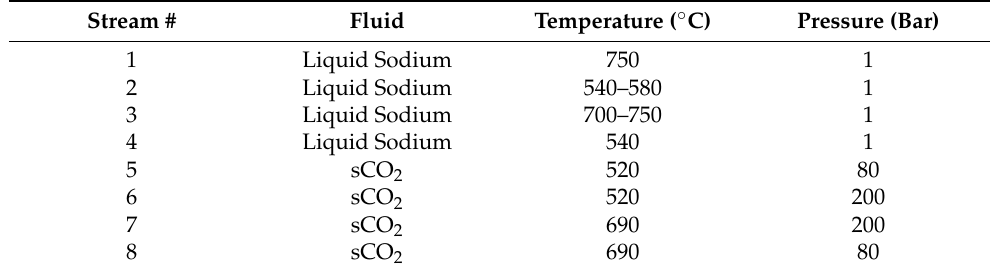
Table 2. Operating Conditions of Analysed Carnot Battery.